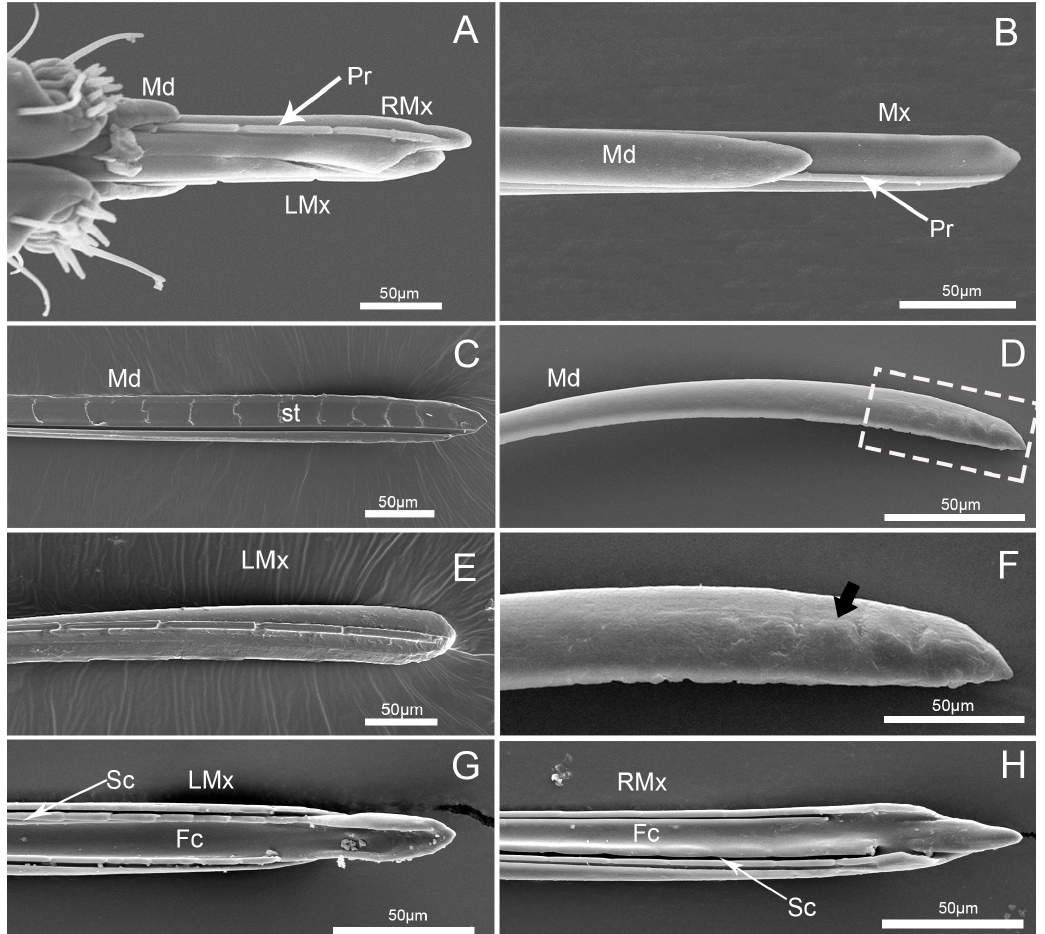
Figure 8. SEM images of stylet of C.nigrescens . ( A ) Enlarged anterior view of apex of stylet fascicle;